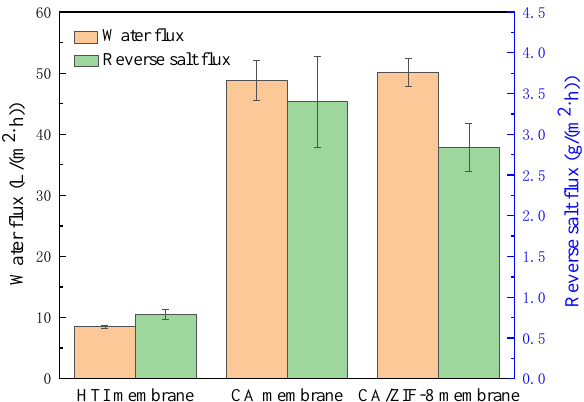
Figure 12. The property of the CA membrane and CA/ZIF-8 membrane.